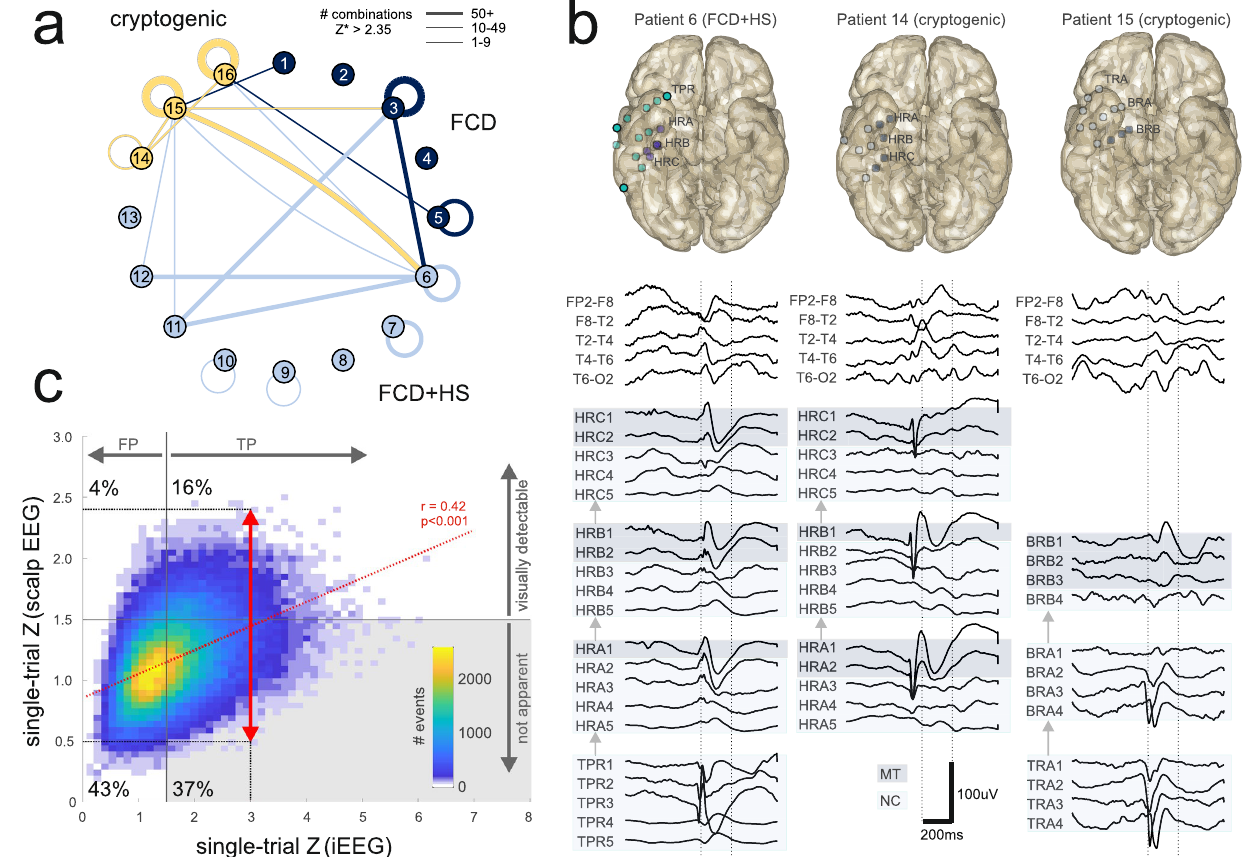
Figure 4. Generalization of template-based intracranial IED detection. ( a ) Cross-patient IED detection illustrated in circular network format. Link thickness represents the number of source-queried channel combinations between two given subjects. Color denotes TLE etiology, for links color is the same same as for the “source” subject. Self-links indicate within-patient detection. FCD focal cortical dysplasia, HS hippocampal sclerosis. ( b ) A fixed template detects intracranial IEDs with similar intracerebral propagation patterns (right temporal pole → right anterior hippocampus → right posterior hippocampus) in three different subjects with different TLE etiologies. The left column shows within-patient detection while the middle and right columns correspond to cross-patient detections. MT channels on a blue background, NC channels on light blue. Intracranial electrode locations are shown in upper panels. ( c ) Distribution of standardized single-trial intracranial and scalp voltage amplitudes for events detected using templates. Voltage signals were subject to filtering (0.5–70 Hz bandpass + 50 Hz notch) before analysis. Plotted scalp amplitude was the maximum over [F7–T1, T1–T3, T3–T5] or [F8–T2, T2–T4, T4–T6] for templates derived from left- or from right-hemisphere channels, respectively. Data were pooled for all supra-threshold template-queried channel combinations (see “Results”). For a fixed intracranial amplitude, scalp amplitudes were variable (red arrow) and proportional to intracranial amplitudes. Grey shaded area indicates intracranial IEDs identifiable as zero-crossing patterns but with scalp voltage amplitudes below an approximate threshold for visual detectability (Z = 1.5). TP true positive, FP false